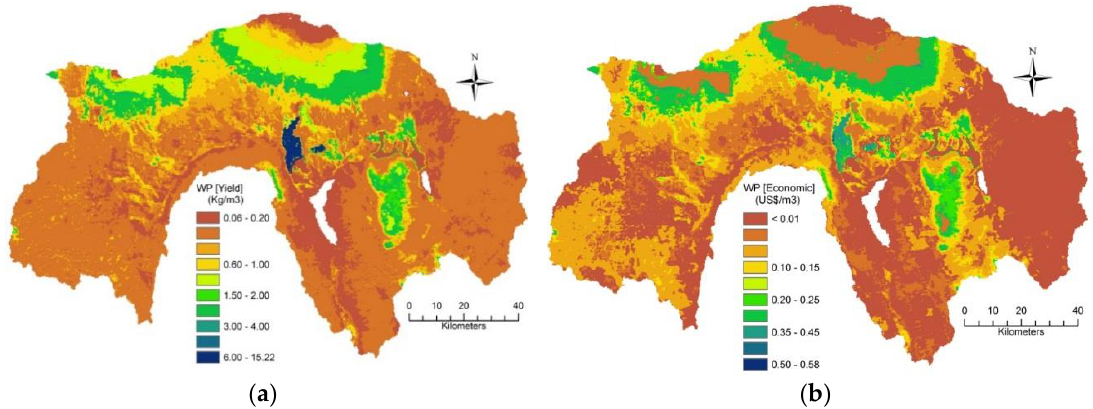
Figure 6. ( a ) Water Productivity (Yield). ( b ) Water Productivity (Economic) for the period of 2008–2010.